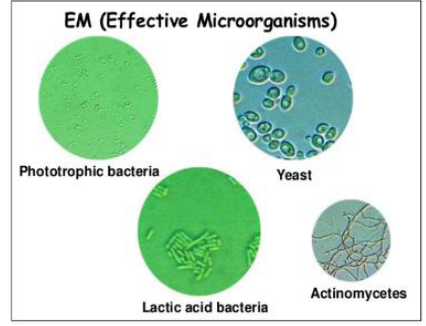
Fig. 1. A composition composed of various strains of aerobic and anaero- bic microorganisms that are part of effective microorganisms